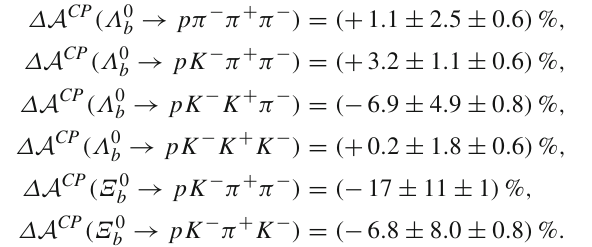
fit model are indicated in the legends. The Λ 0 includes two components: the partially reconstructed Λ 0 → p π − π + π − π 0 decays where a γ or π 0 is not reconstructed. and Λ 0 b The latter has a lower-mass